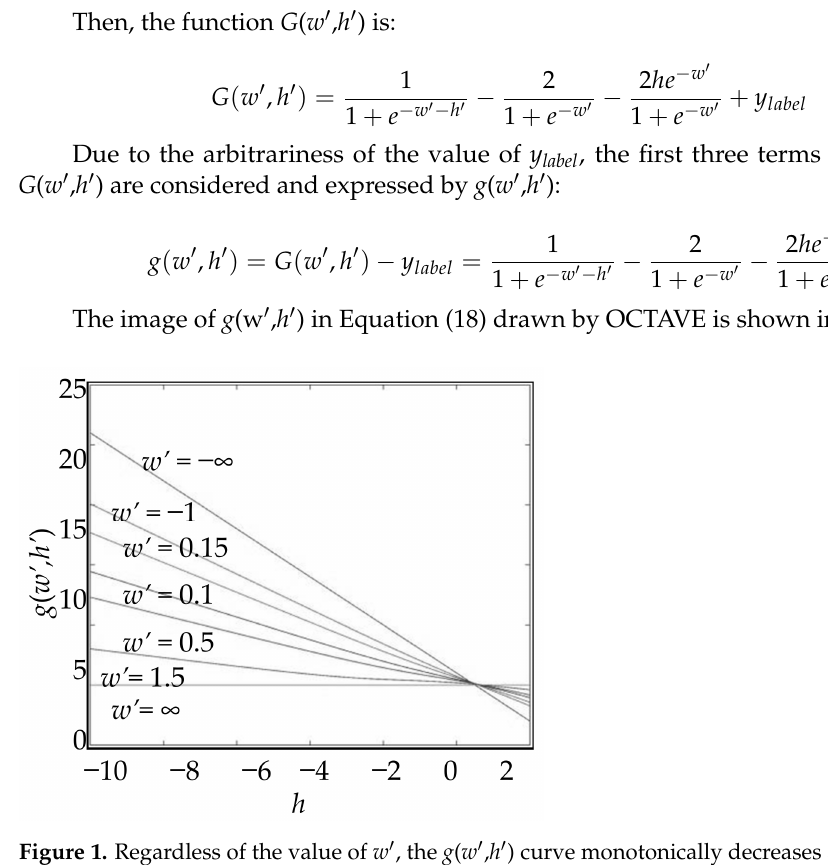
Figure 1. Regardless of the value of w (cid:48) , the g ( w (cid:48) , h (cid:48) ) curve monotonically decreases and intersects the x -axis at the point (0.5, 0). This means that when the conditions ( σ = sigmoid, h (cid:48) ≤ 0.5, and y label > 0) are met, the algorithm has the possibility of